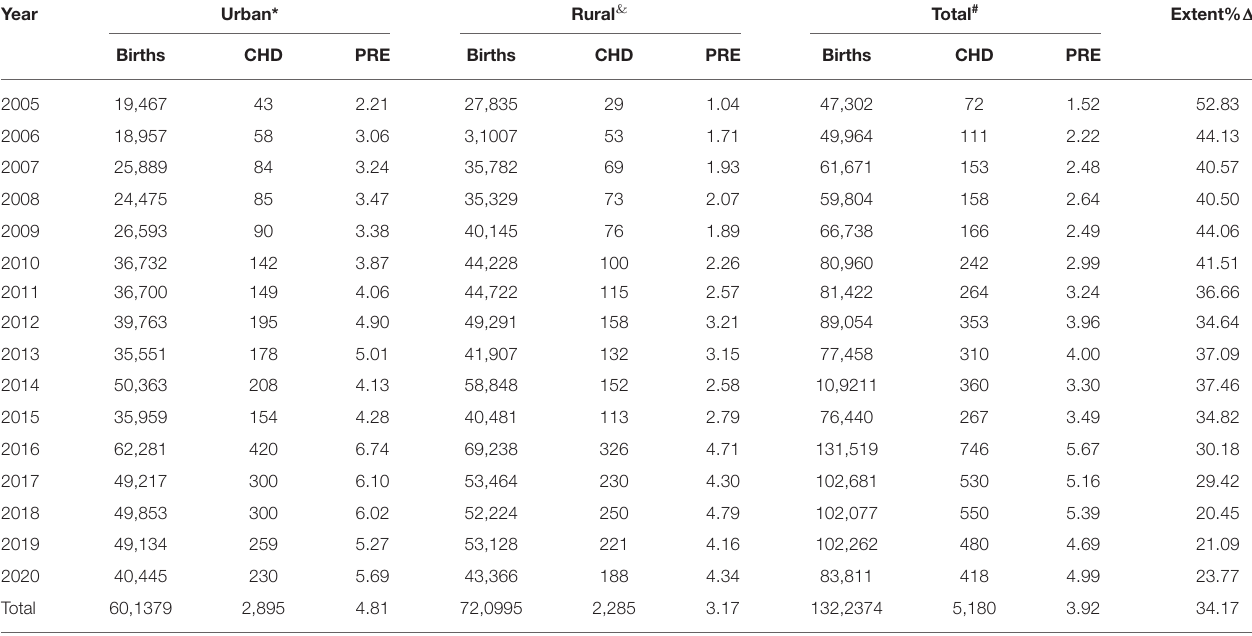
TABLE 1 | The prevalence of CHD between urban areas and rural areas from 2005 to 2020. Year Urban* Rural & Total # Extent% 1 $